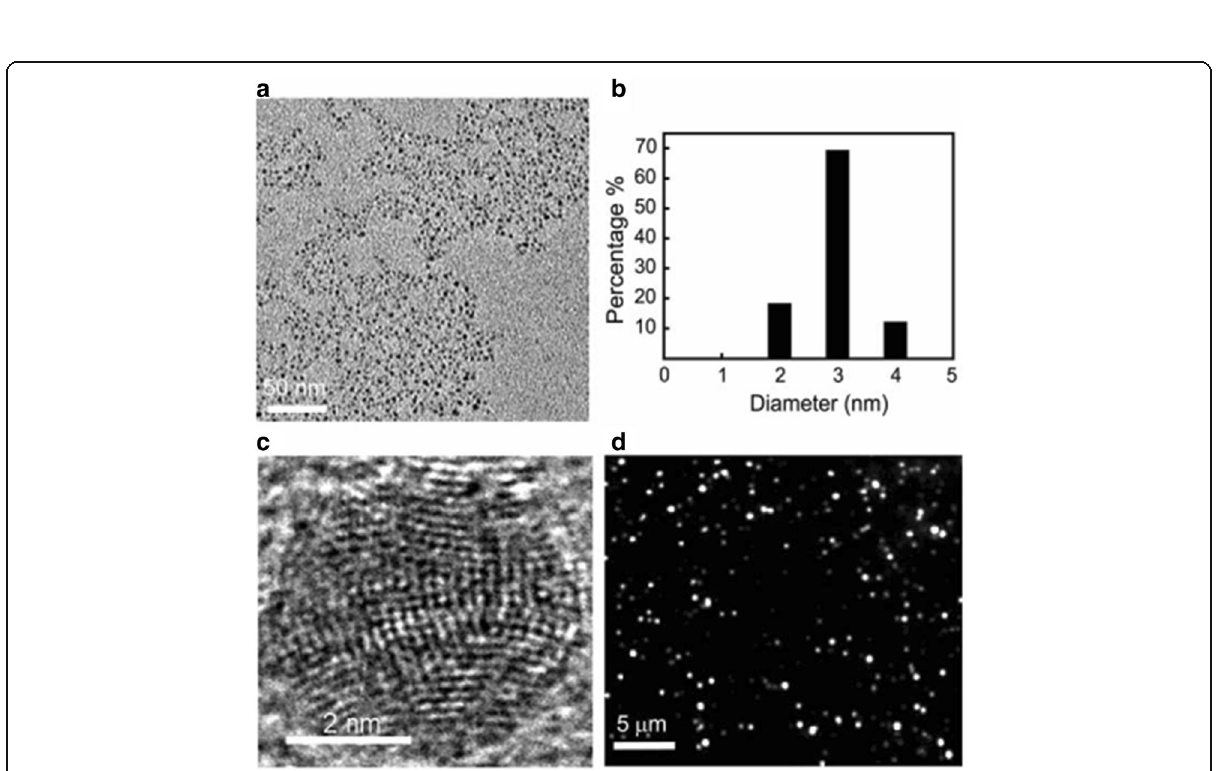
Fig. 8 Size distribution, structure, and luminescence emission of the 3 nm silver nanoparticles created using solid-phase thermolysis. a Low-resolution TEM image of these nanoparticles. b Size distribution of the nanoparticles determined from TEM. c High-resolution TEM image of such a small silver nanoparticles shows a highly multi-domain structure. d Luminescence image of these small silver nanoparticles taken under 488 nm laser excitation at ~10 W/cm 2